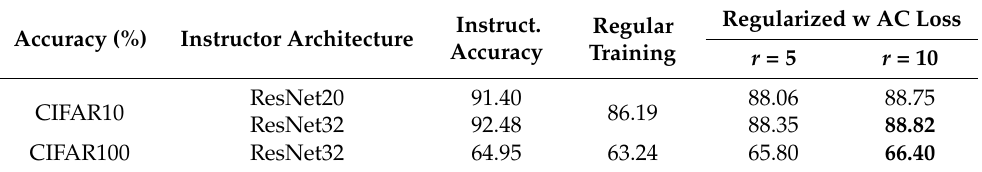
Table 6. Knowledge transfer via AC loss to student models with NiN architecture, and instructors with ResNet